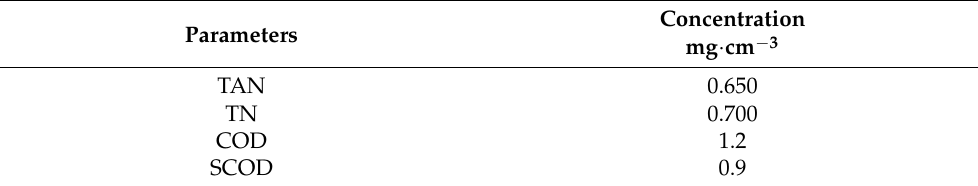
Table 6. Concentration setting value of each parameter on the